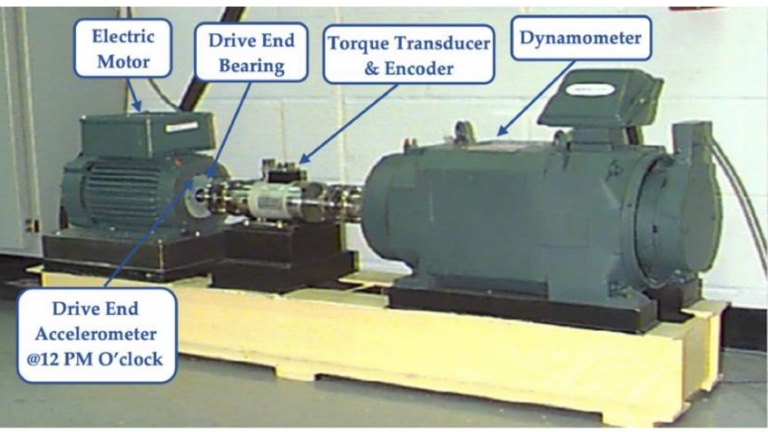
Figure 1. The experimental testing rig.